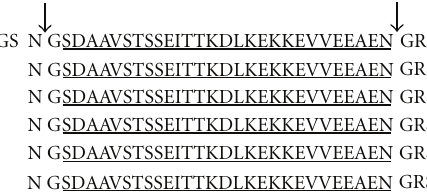
Figure 3: The sequence and hydroxylamine cleavage sites of the concatemer protein. The concatemer protein contained a total of 200 amino acids, and the molecular weight of the concatemer protein was approximately 23kD. The 6 × T α 1 sequence is underlined, and the cleavage sites Asn-Gly are indicated with a vertical